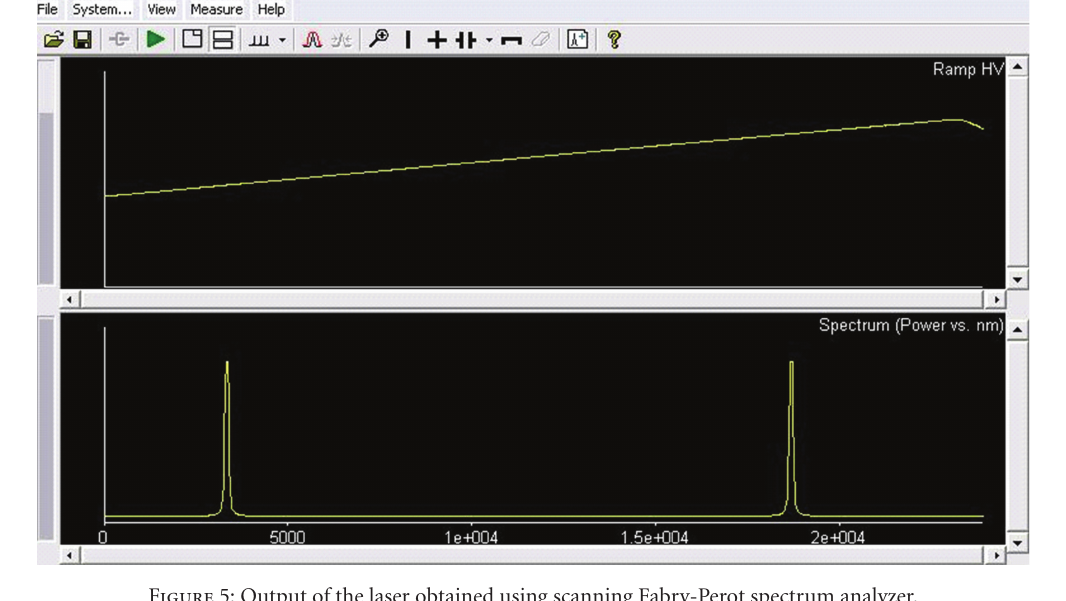
Figure 5: Output of the laser obtained using scanning Fabry-Perot spectrum analyzer.